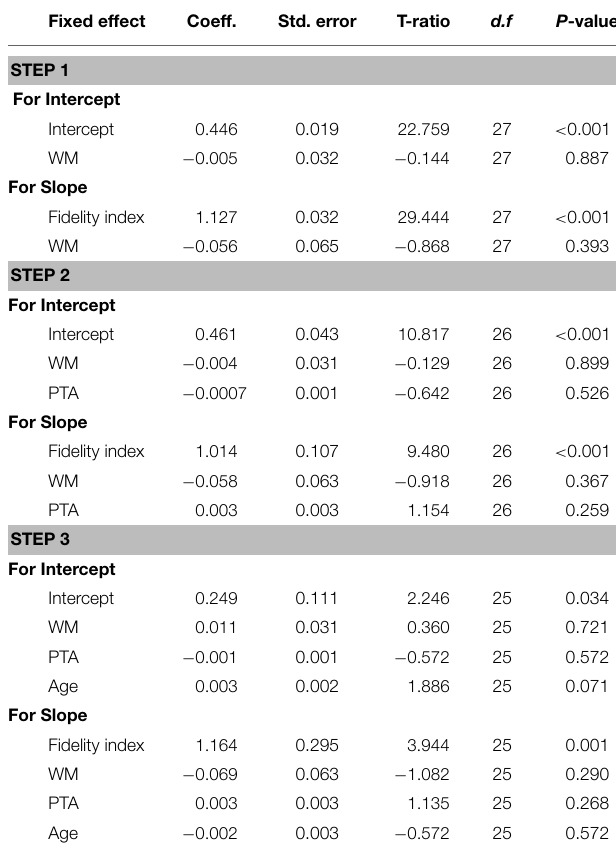
TABLE 5 | Summary of hierarchical linear model for quality with working memory capacity (WM) as a